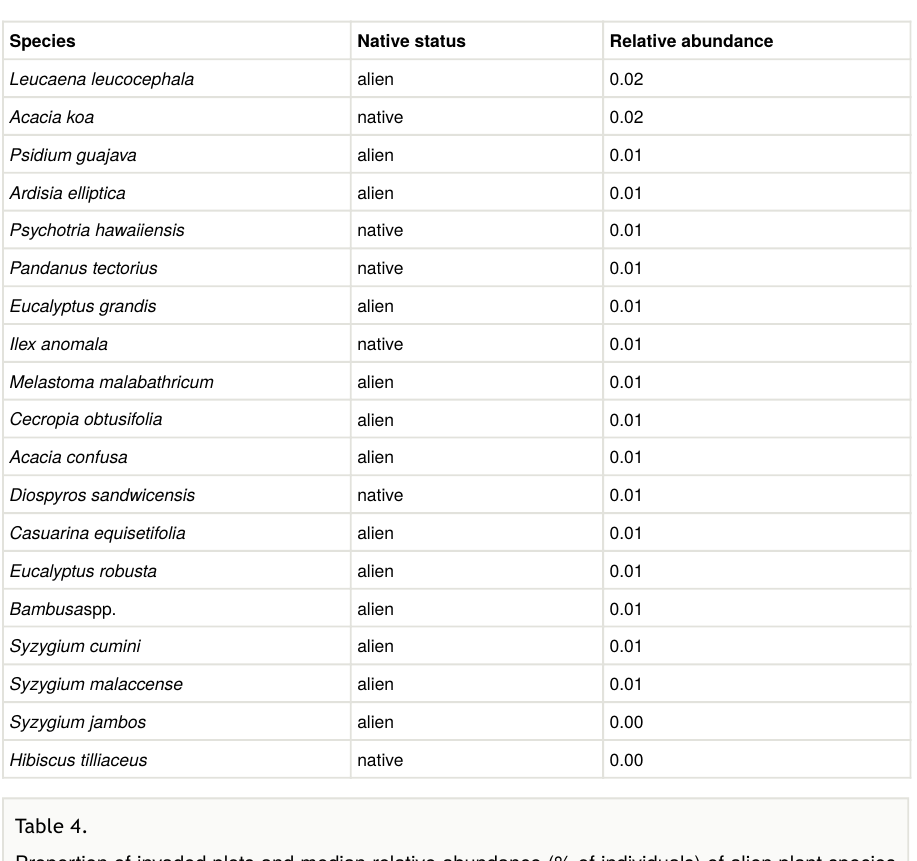
Proportion of invaded plots and median relative abundance (% of individuals) of alien plant species in invaded plots per island across the Hawaiian archipelago in